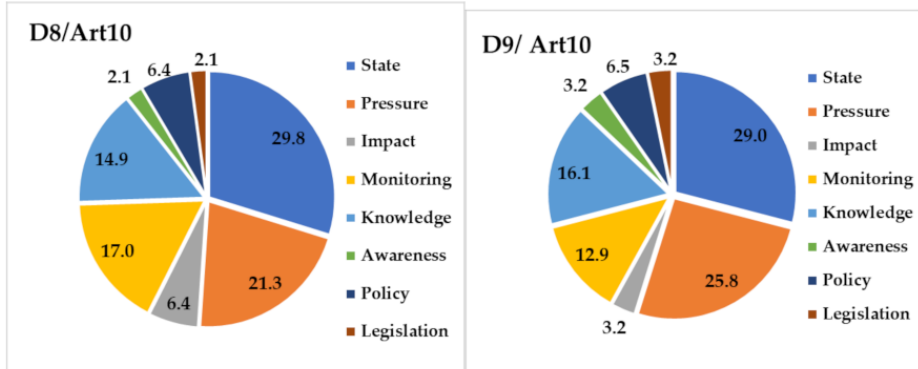
Figure 11. Type of environmental targets and associated indicators established by Mediterranean MSs for Contaminants Descriptors in